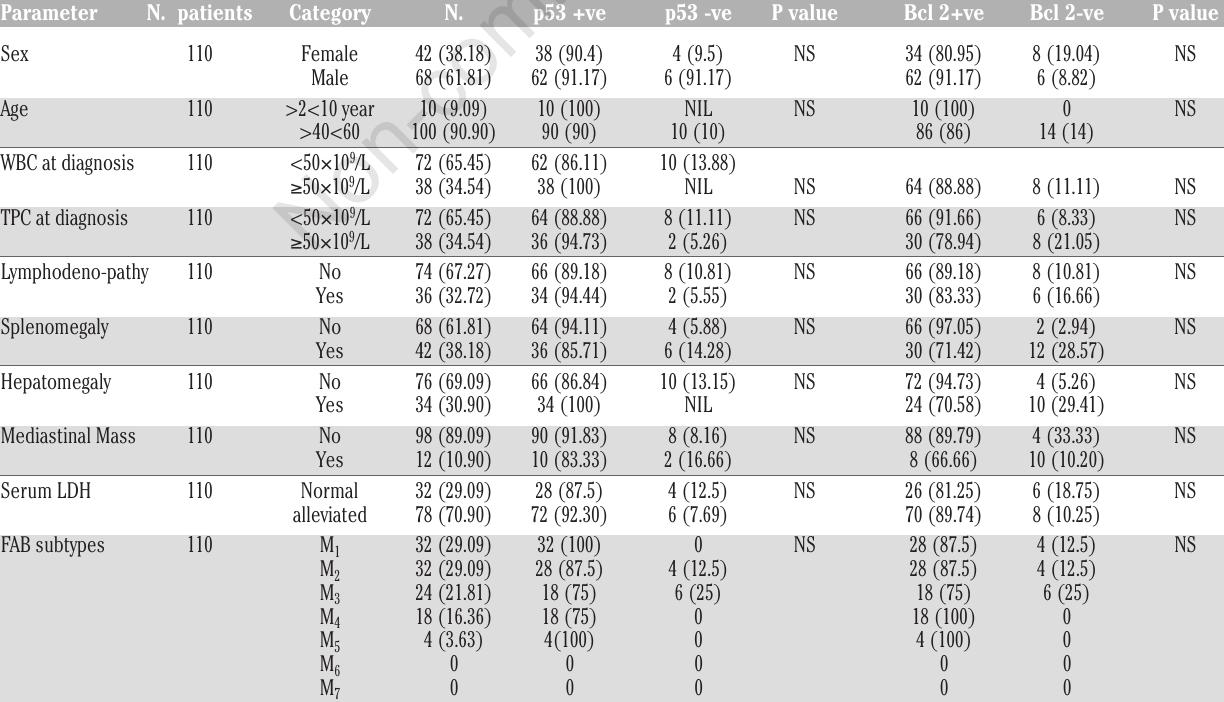
Table 1. Patients’ characteristics according to P53 and BCL-2 immunostaining (n=110). Parameter N.